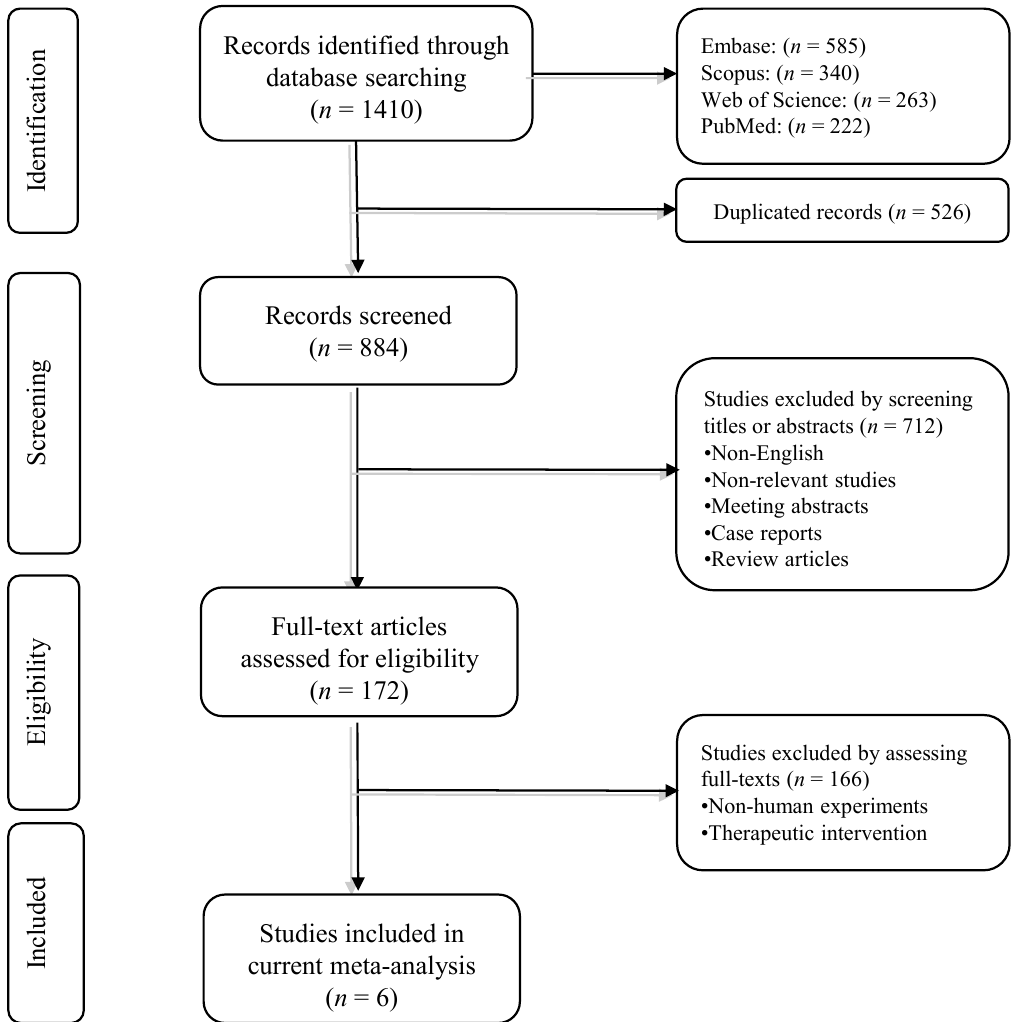
Figure 1. The flowchart of the study selection process.